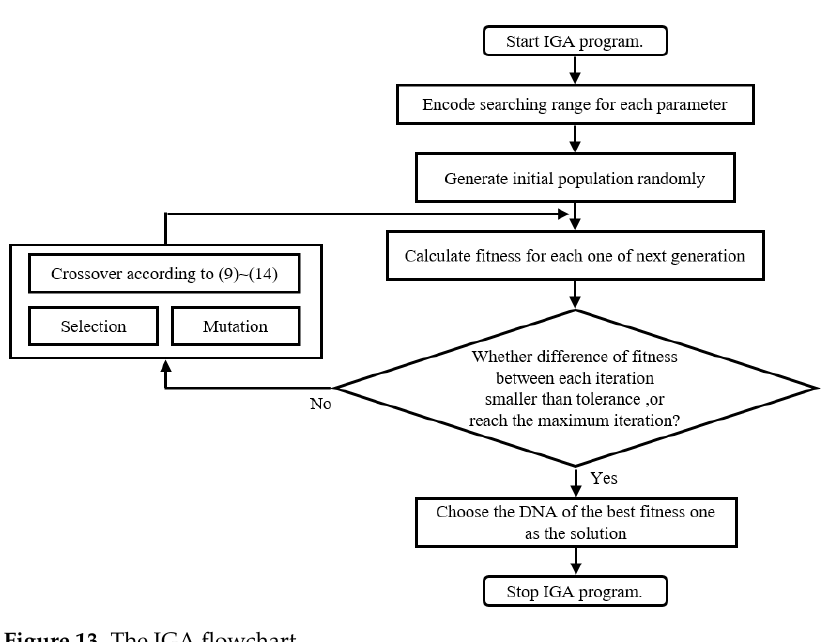
Figure 13. The IGA flowchart .